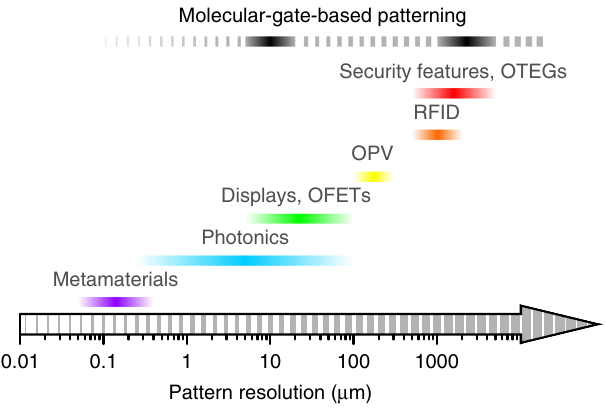
Fig. 6 Typical length scales required for patterning organic semiconductors. The characteristic dimensions are shown for metamaterials, photonic structures, displays, organic fi eld-effect transistors (OFETs), organic photovoltaics (OPV), RFID tags, security features and organic thermoelectric generators (OTEGs). Pattern resolutions obtained in the present work are indicated by solid black bars, with broken bars showing their plausible